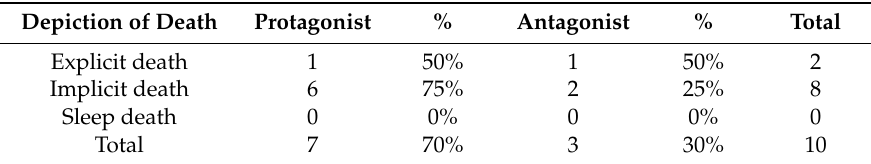
Table 1. Depiction of Death by Character Type